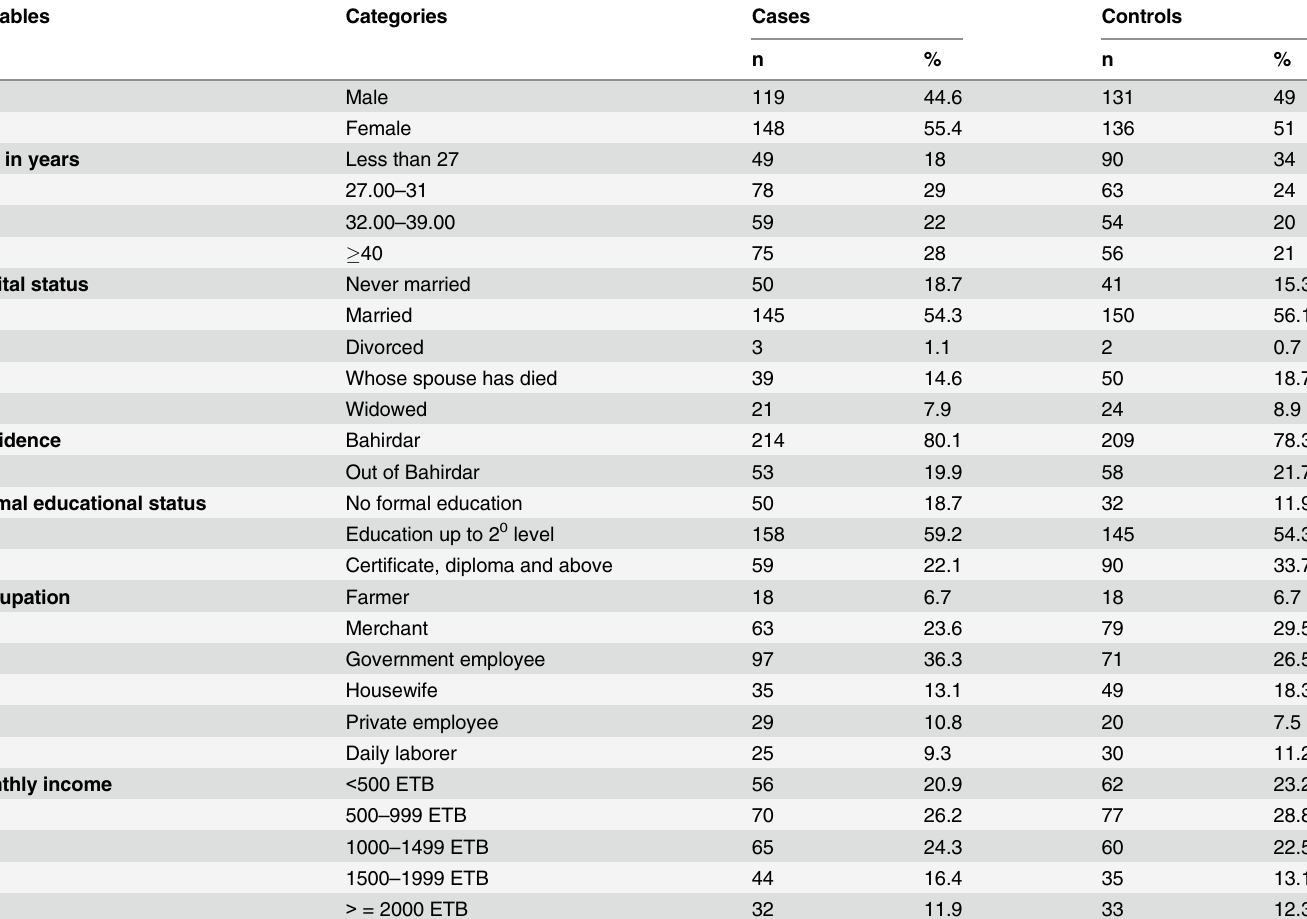
Table 1. Socio-demographic and economic characteristics of Adult PLHA who had undertaken initial CD4 count at Bahirdar FHRH, January 2010 to December